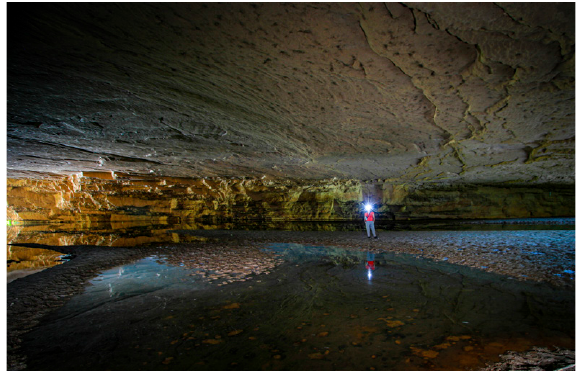
Figure 2. Gruta do Catão, São Desidério, Bahia state, Brazil. Photo by A. Lobo.